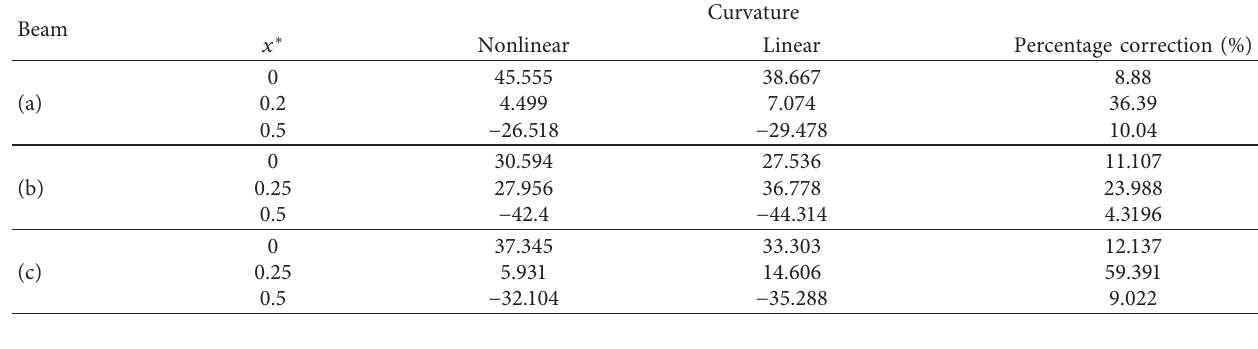
Table 10: The percentage correction between the curvatures estimated via the linear and nonlinear theories. Maximum nondimensional � 1 . 5). amplitudes ( W ∗ max